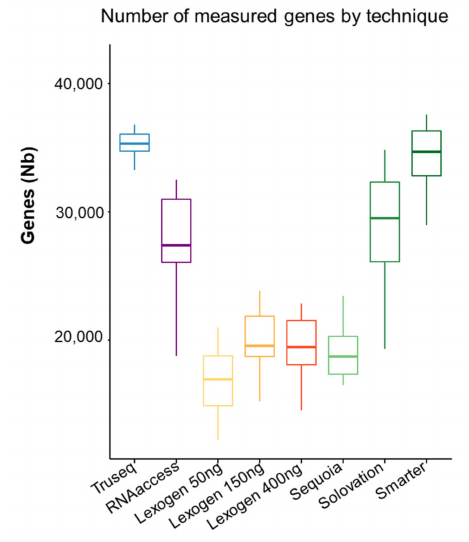
Figure 1. Number of expressed genes according to RNA sequencing